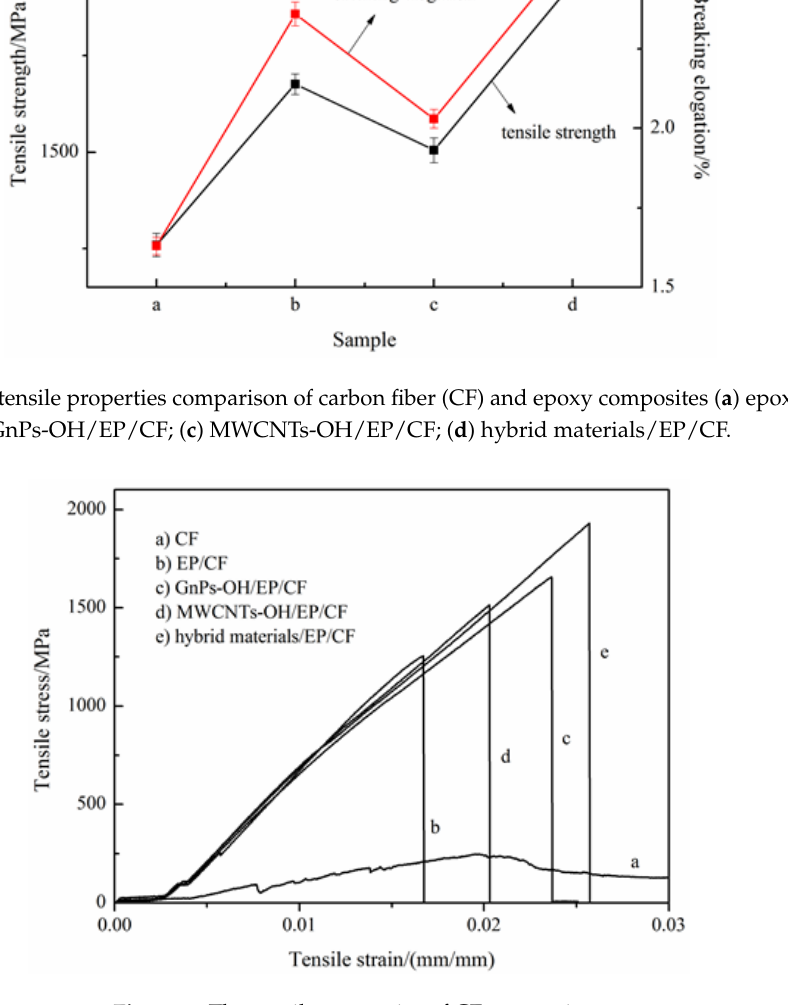
Figure 9. The tensile properties of CF composites.